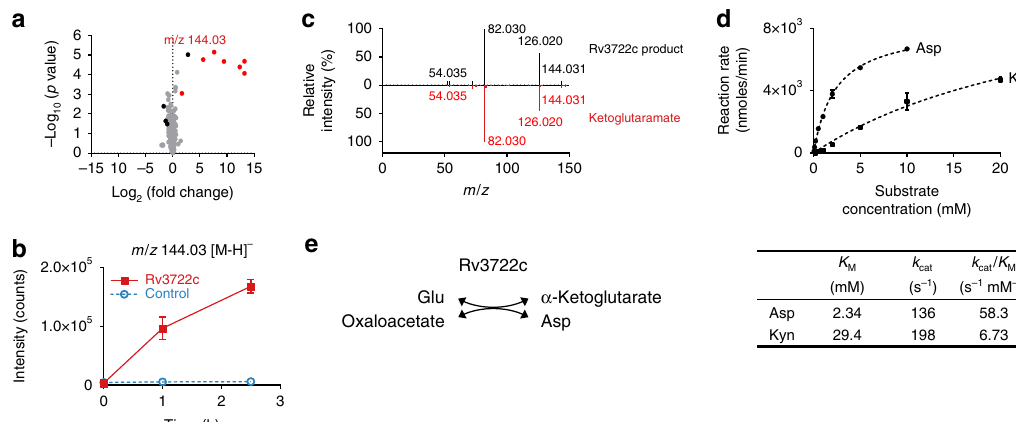
Fig. 3 Rv3722c functions as an aspartate aminotransferase. a Volcano plot of activity-based metabolite pro fi ling with puri fi ed recombinant Rv3722c. Puri fi ed recombinant Rv3722c (10 µ M) was incubated with a mycobacterial metabolite extract for 0 h or 2.5 h at 37 °C and analyzed using untargeted LC- MS. Each dot represents a feature (a chromatographic peak with a speci fi c m/z) in the negative ionization mode; red dots represent features related (fragments, adducts, dimers, and isotopes) to the feature with m/z 144.03 [M – H] − , while black dots represent uncharacterized features with a fold change greater than two and p -value below 0.05 ( n = 3). b Timecourse of Rv3722c-dependent formation of m/z 144.03. Same as a , but data shown for 0, 1, and 2.5 h, in the presence of active Rv3722c and heat-inactivated Rv3722c control (10 min 95 °C) (mean + / − SD of three experimental replicates ( n = 3) representative of at least two independent experiments). c MS fragmentation spectra of the Rv3722c reaction product with m/z 144.03 and in-house synthesized ketoglutaramate at a collision energy of 10 V. d Steady-state enzyme kinetics of Rv3722c. Puri fi ed recombinant Rv3722c (0.01 µ M) was incubated with 10 mM α -ketoglutarate and increasing concentrations of amino donors at 37 °C. Glu formation was measured by RapidFire mass spectrometry and used to determine initial reaction rates. The data were fi tted to Michaelis – Menten kinetics using Graphpad Prism software, and are represented as mean + / − SD of three experimental replicates ( n = 3) (Kyn: kynurenine). e Aminotransferase reaction catalyzed by Rv3722c. See also Supplementary Figs. 3 and 4. Source data are provided as a Source Data fi